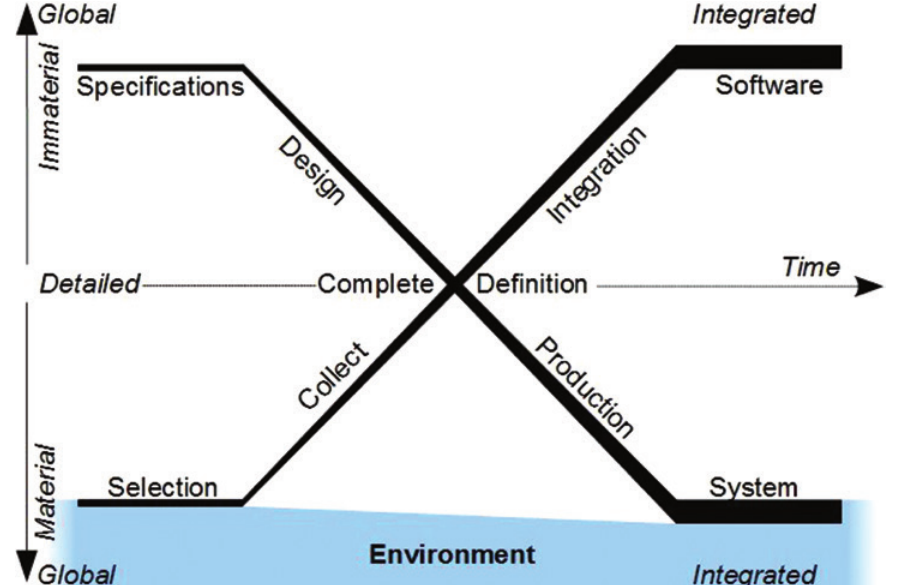
Figure 9: General Scheme of the X Development